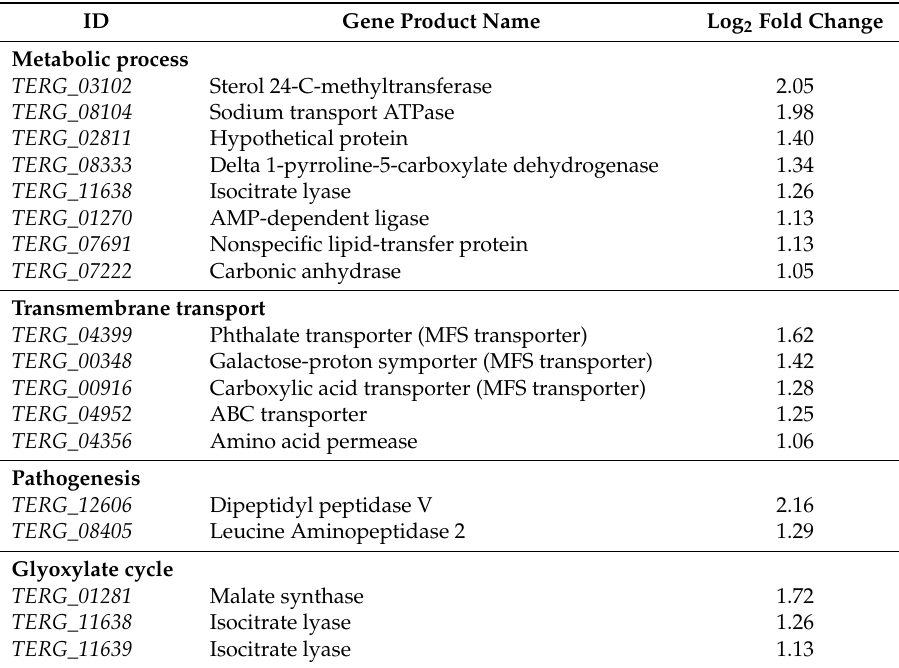
Table 3. Some functional categories and related genes important for the pathogenesis of T. rubrum.